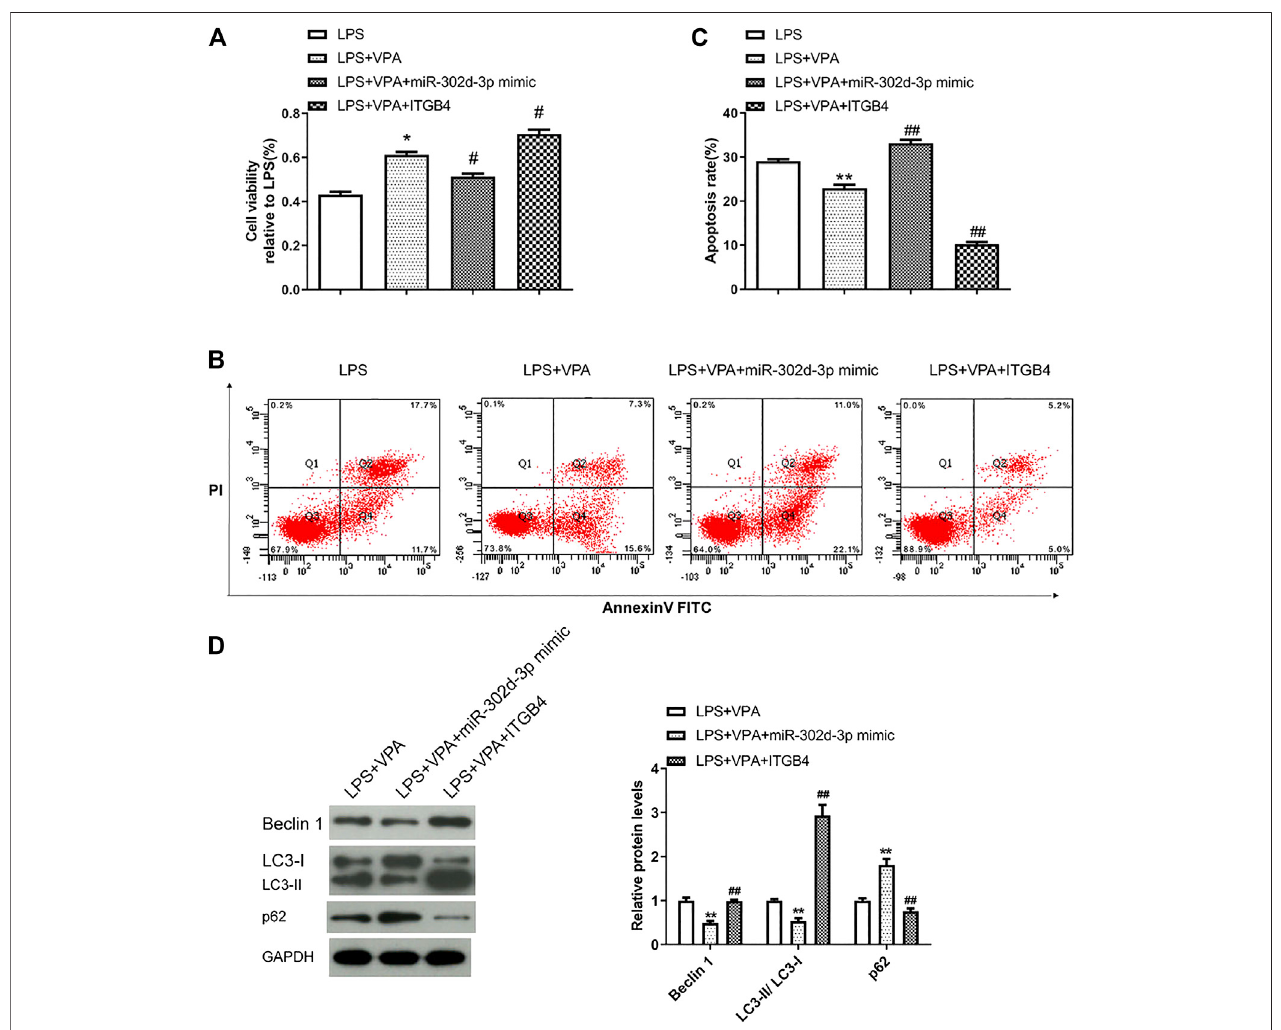
FIGURE6| VPApreventschondrocytesfromLPS-induceddamagethroughregulatingmiR-302d-3p/ITGB4. (A) CellviabilitywasmeasuredbyCCK-9assay.* p < 0.05, # p < 0.05. (B,C) Flow cytometry assay showed the apoptosis rate of chondrocytes after various treatments and speci fi c transfection. ** p < 0.01, ## p < 0.01. (D) Western blot analysis of autophagy-related proteins in CHON-001 cells transfected with miR-302d-3p mimic or pcDNA3.1-ITGB4 and then treated with LPS and VPA. ** p < 0.01, ## p < 0.01. Results are the average of three individual experiments in triplicate with error bars indicating mean ± SD (ANOVA followed by Tukey ’ s post hoc